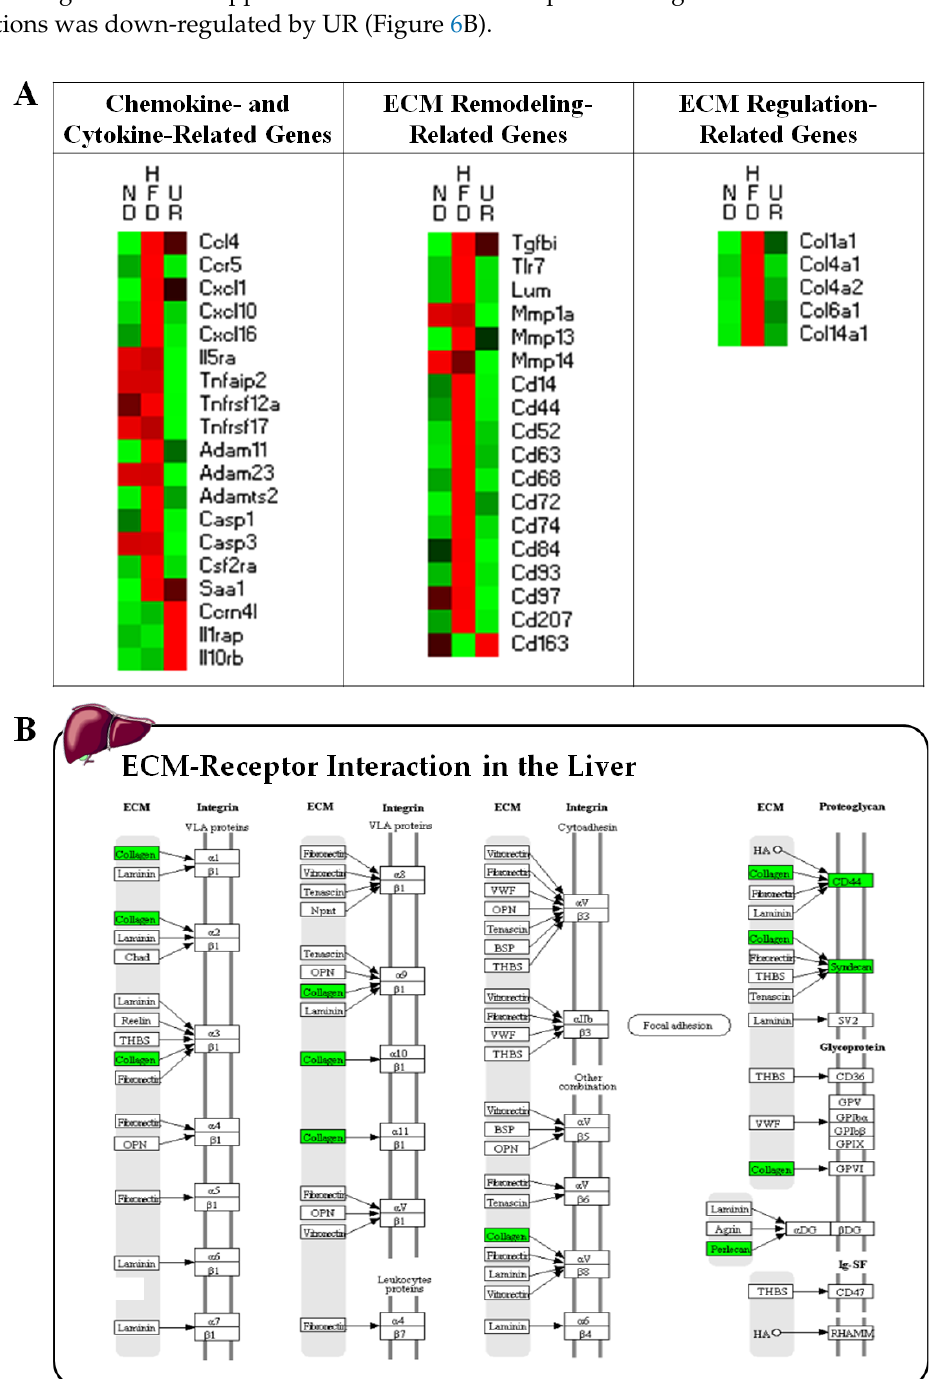
Figure 6. Effect of ursolic acid (UR) treatment on the transcription patterns of hepatic genes related to chemokine/cytokine expression, extracellular matrix (ECM) remodeling, and ECM regulation ( A ); and ECM–receptor interaction ( B ). Symbols in red indicate genes that were up-regulated while those in green denote genes that were down-regulated. UR down-regulated collagen, Cd44, Syndecan and Perlecan gene expressions involved in ECM-receptor interaction compared to HFD. In contrast to our hepatic microarray results, UR increased the expression of muscular genes involved in cytokine/chemokine expression ( Adam9 , Cxcl4 , Il15 , Itgbl1 , and Itgb1bp3 ), ECM